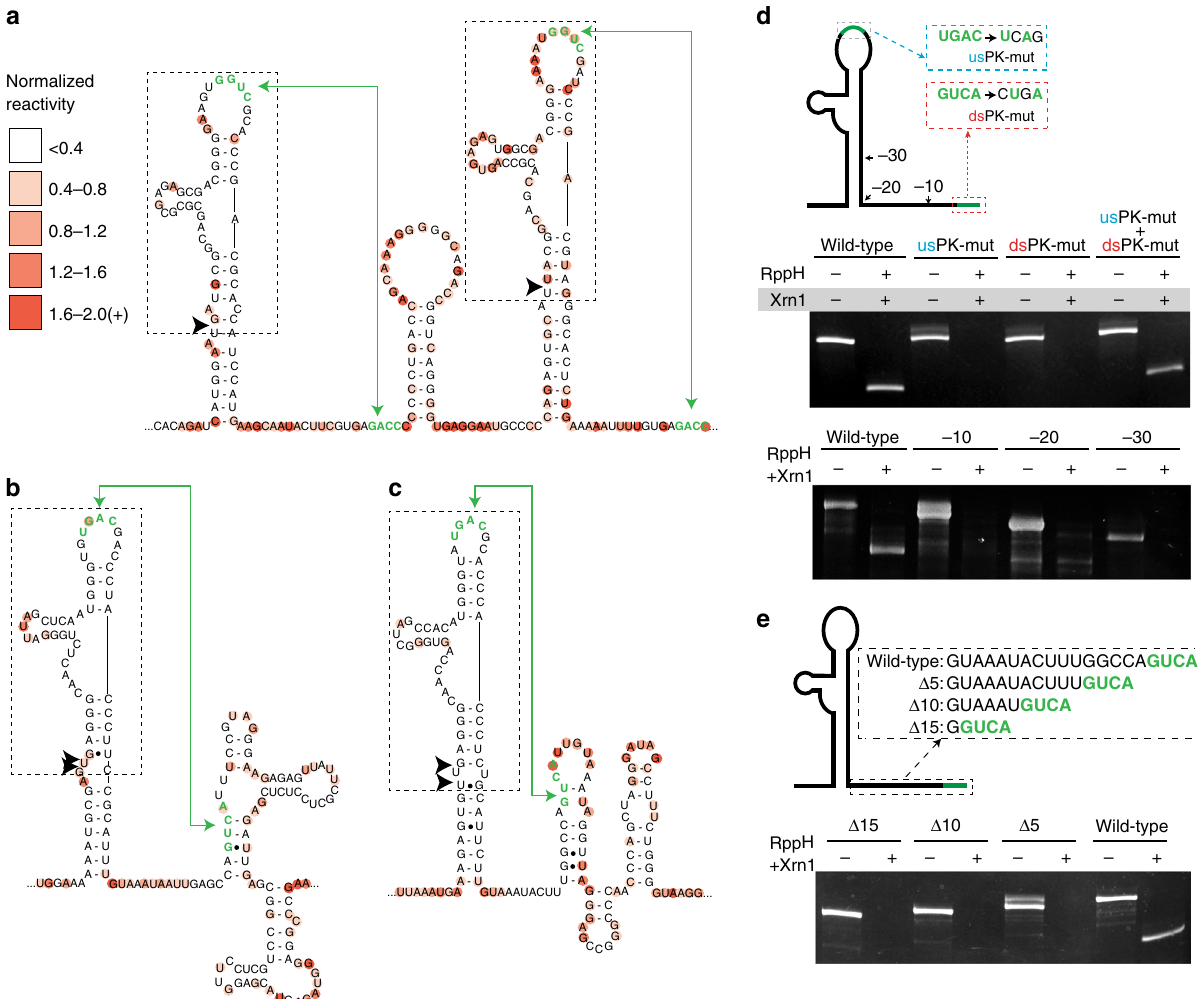
Fig. 5 Characterization of NKVFV and TBFV xrRNAs. Secondary structures of relevant parts of the 3 ′ -UTRs of a TBEV, b MMLV, and c MODV. The mapped Xrn1 halt site is indicated with black arrows. Nucleotides are shaded to indicate their normalized SHAPE reactivity. d Xrn1 resistance assay using wild-type, mutant, and truncated MODV xrRNA. The diagram at the top shows the mutations made. e Same as d , with deletions to the single-stranded RNA upstream of the 3 ′ part of the putative long-range interaction. Accession numbers for RNA sequences used: TBEV, NC_001672; MMLV, MC_004119; MODV, NC_003635. Gels are representative of greater than three independent